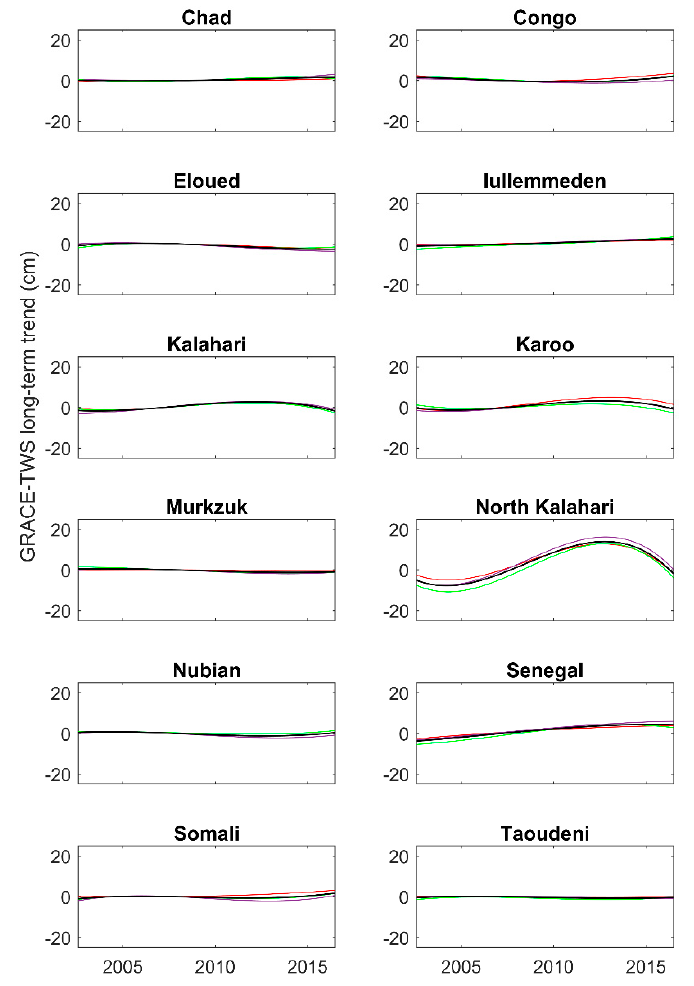
Figure 4. Long-term patterns in TWS anomaly changes for each of major aquifer basins in Africa as derived from adding a cubic polynomial within the modelling. The ensemble GRACE product is shown in black; CSR product red, MSCN product blue, and GRGS product in green.